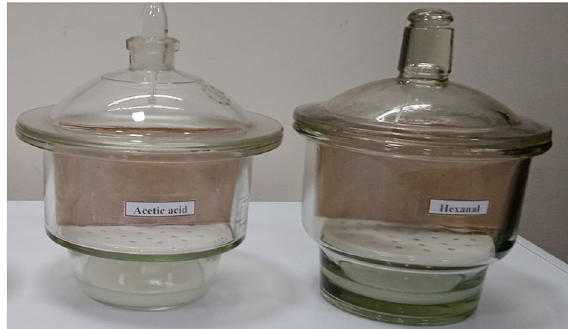
Figure1. Paper exposed to VOCs in a